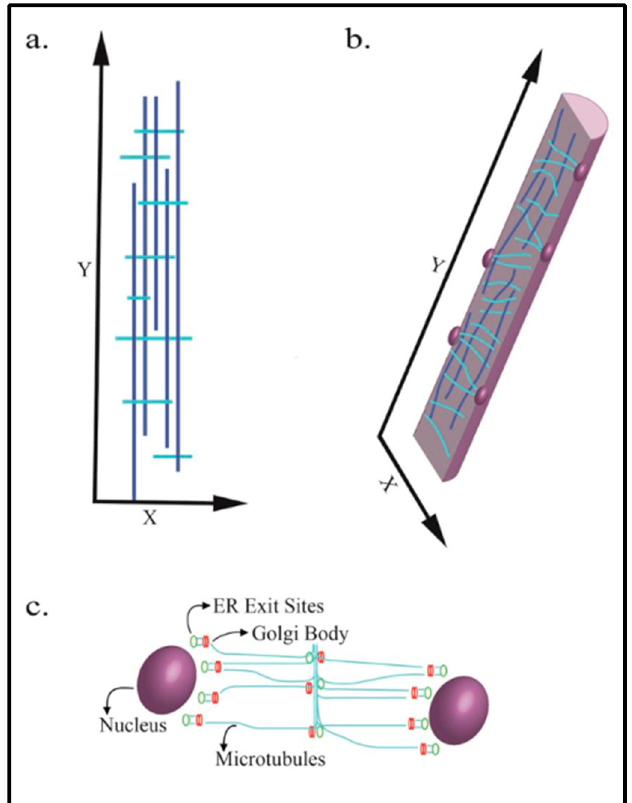
Figure 1. Microtubule arrangement in mature skeletal muscle myofibers. The dark vertical blue lines indicate longitudinal microtubules. Light blue lines indicate transverse microtubules. ( a ) Myofiber microtubules are arranged in a paraxial array; ( b ) the appearance of microtubules in a cross-section of a myofiber. Nuclei are shown on the internal periphery of the myofiber; ( c ) the microtubule nucleation points within a myofiber.